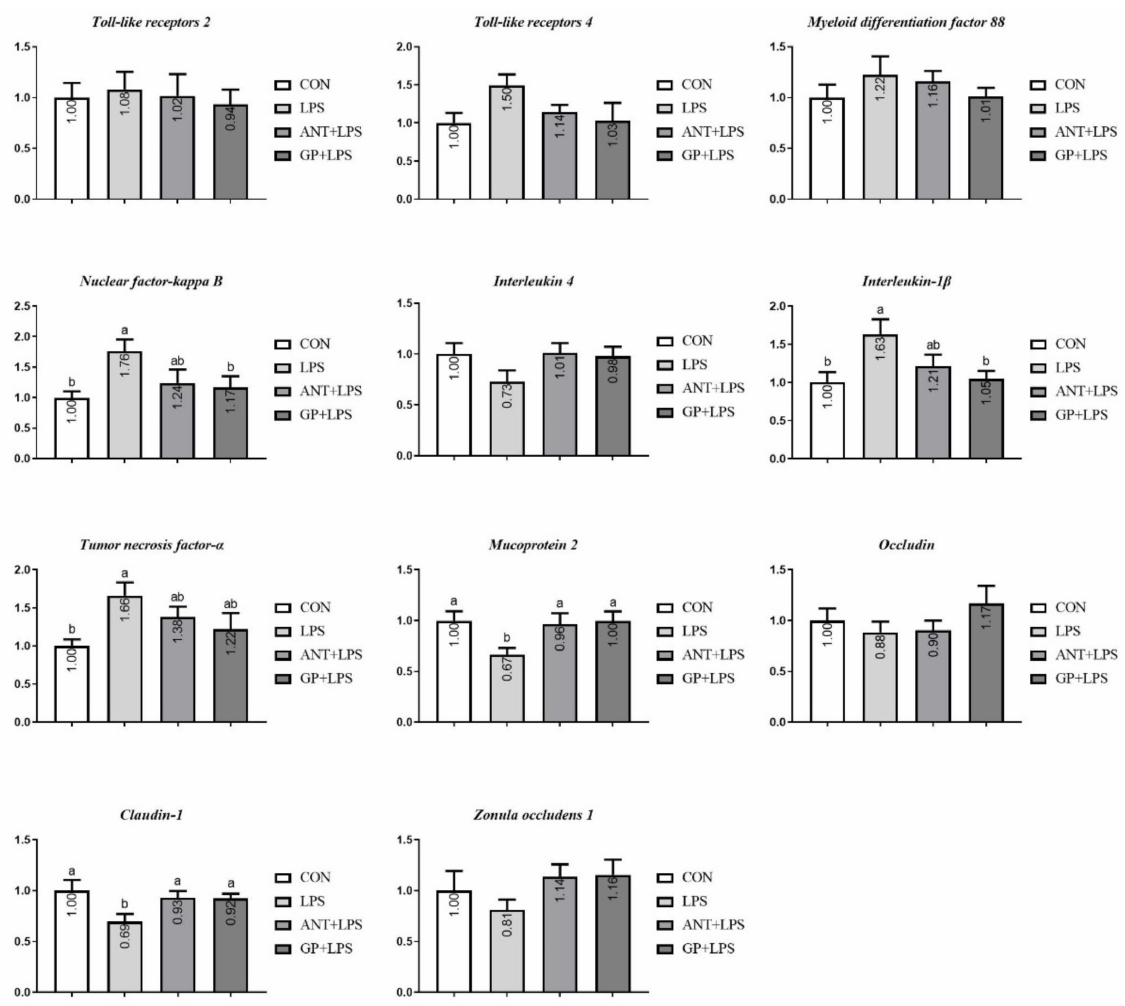
Figure 7. Effects of dietary garlic powder inclusion on relative gene expression of inflammatory cytokines and tight junction in jejunum mucosa of broilers challenged with lipopolysaccharide (data were presented as mean and SEM, means that do not share the same superscript are significantly different, p <